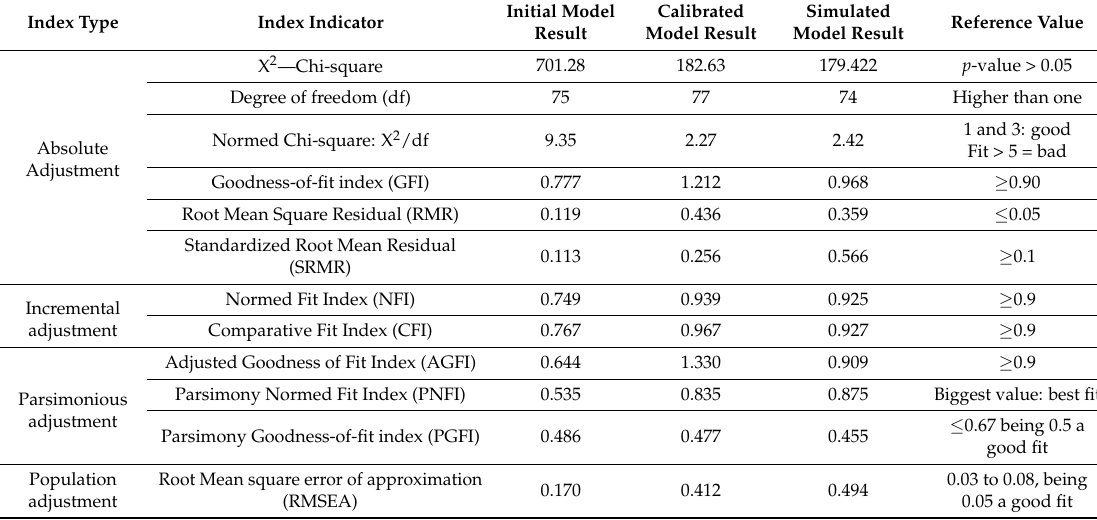
Table 2. Adjustment measures for the